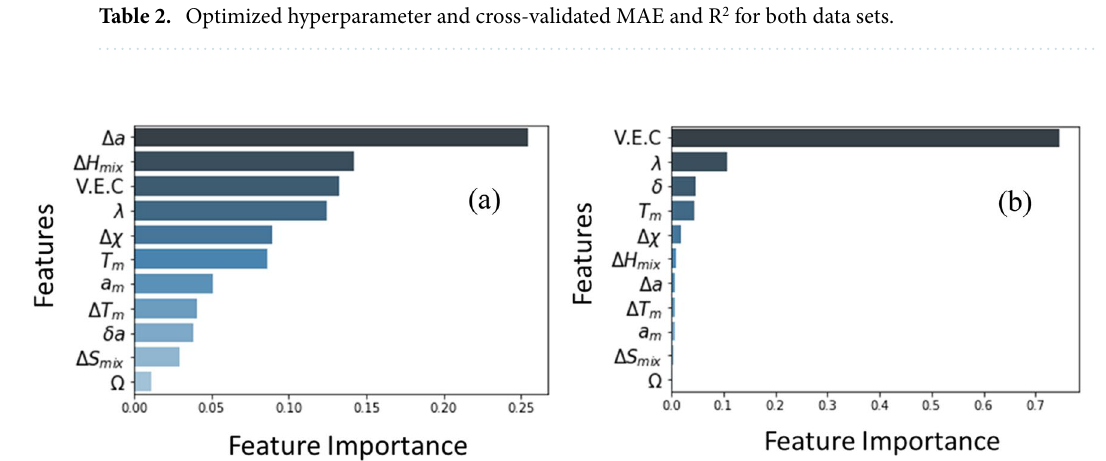
Figure 2. Feature importance for (a) larger training set containing both refractory and non-refractory alloys, (b) smaller training set containing only refractory